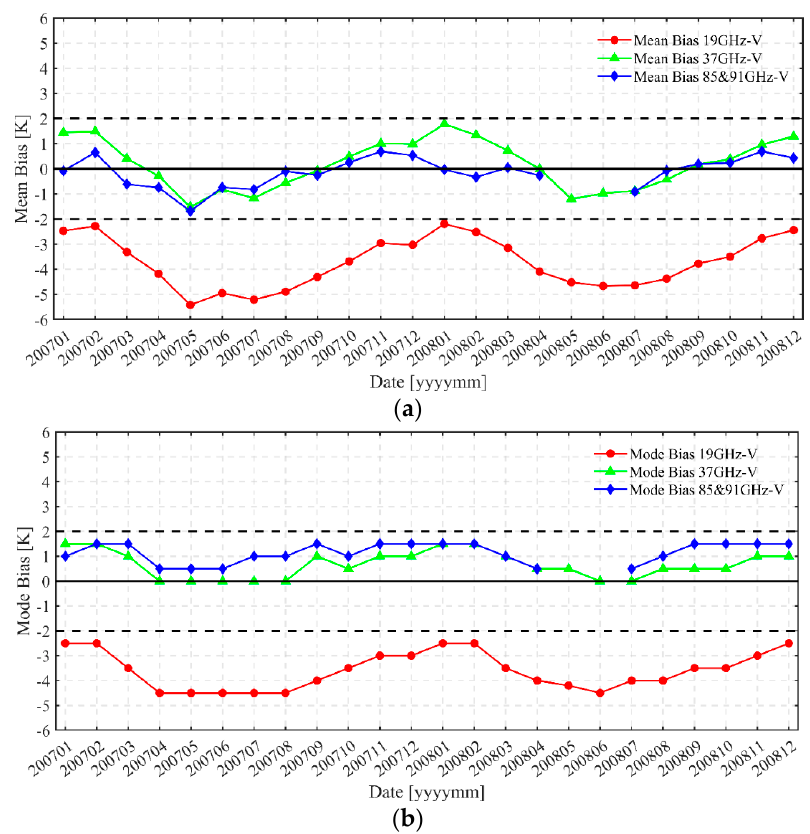
Figure 13. Time series of biases between SSM / I and SSMIS: ( a ) mean bias; ( b ) mode of bias. Black dotted lines denote biases of ± 2 K.